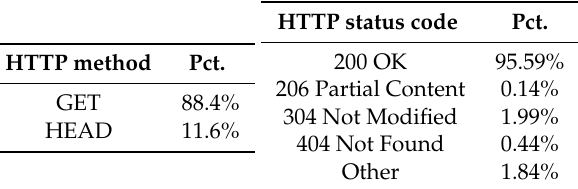
Table 5. HTTP method and HTTP status code